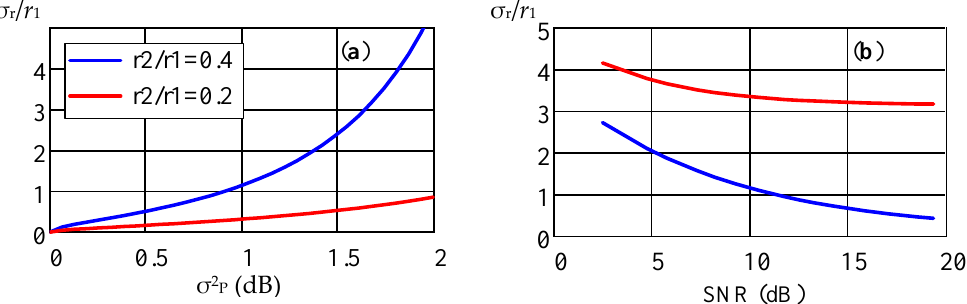
Figure 8. Dependences of the normalized standard deviation σ r / r 1 of the estimate r 1 on the parameter σ 2P ( a ) and the SNR ratio ( b ).